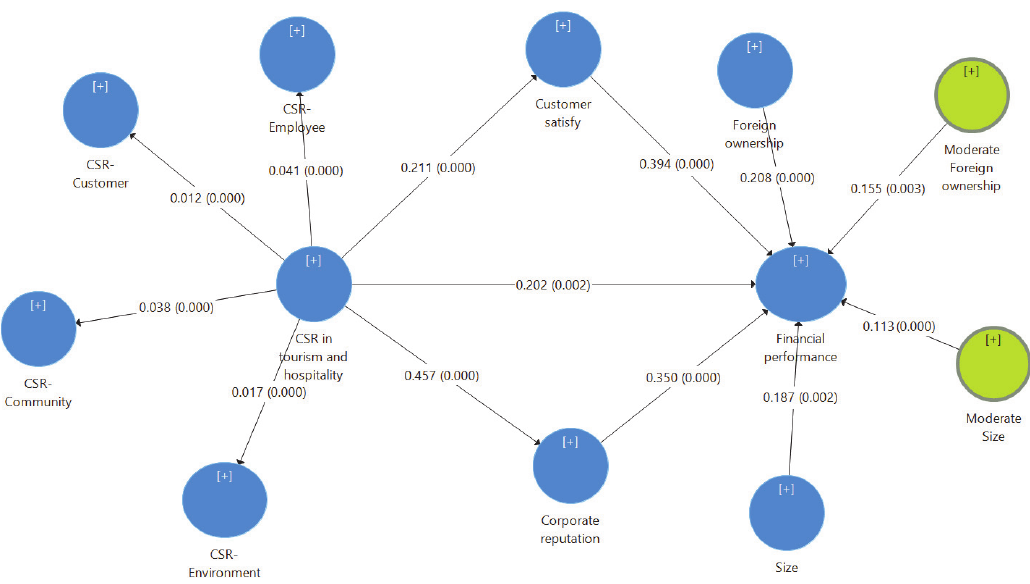
Fig. 3. Results of the moderator role test (Bootstrap